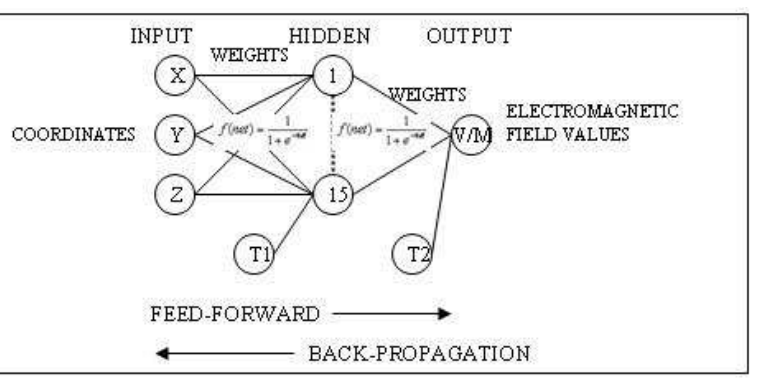
Figure 8. The topology of artificial neural networks for spatial interpolation of electromagnetic field values; x-y-z are the input coordinates, T1 and T2 are threshold matrixes, V/M is electromagnetic field value and 15 neurons in the hidden layer.